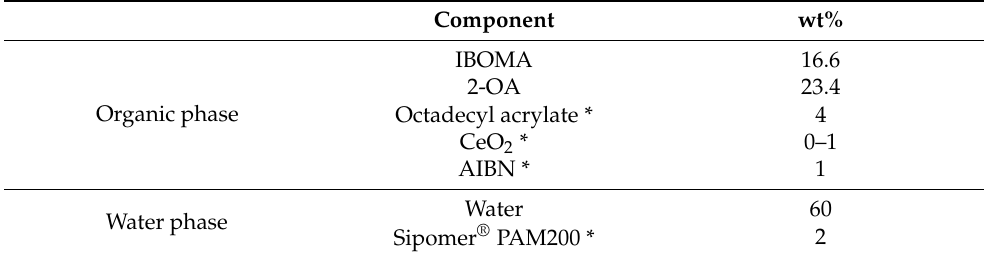
Table 1. Formulation used for the miniemulsion polymerization. The target solids content was 40